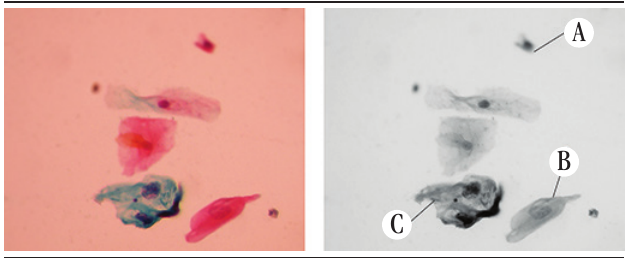
figuRE 2 − Low-grade anal lesion (Papanicolaou stain, 40×), clear background